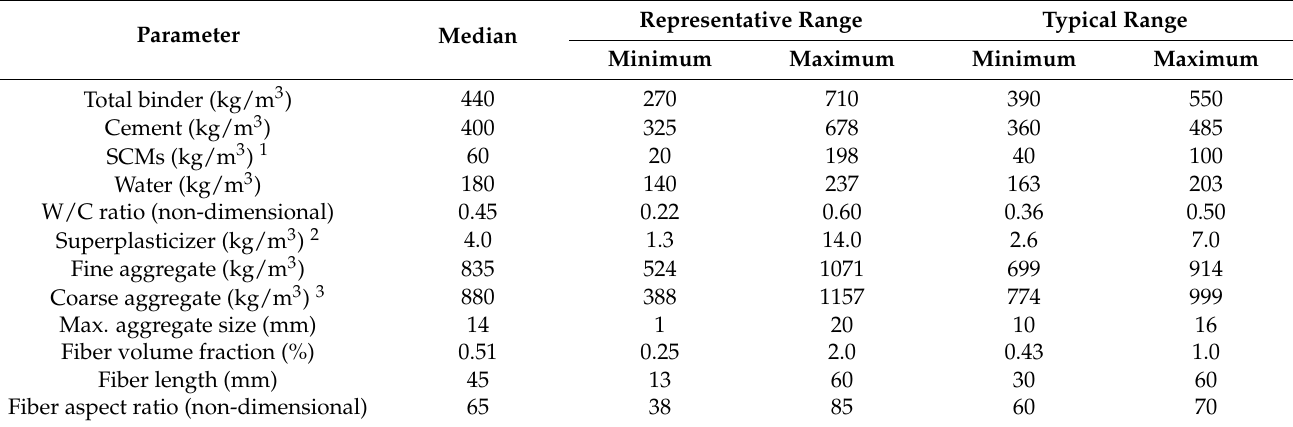
Table 2. Representative values for the SFRC mixtures in the